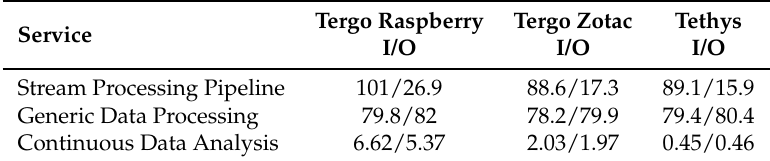
Table 4. Network I/O operations in MB.